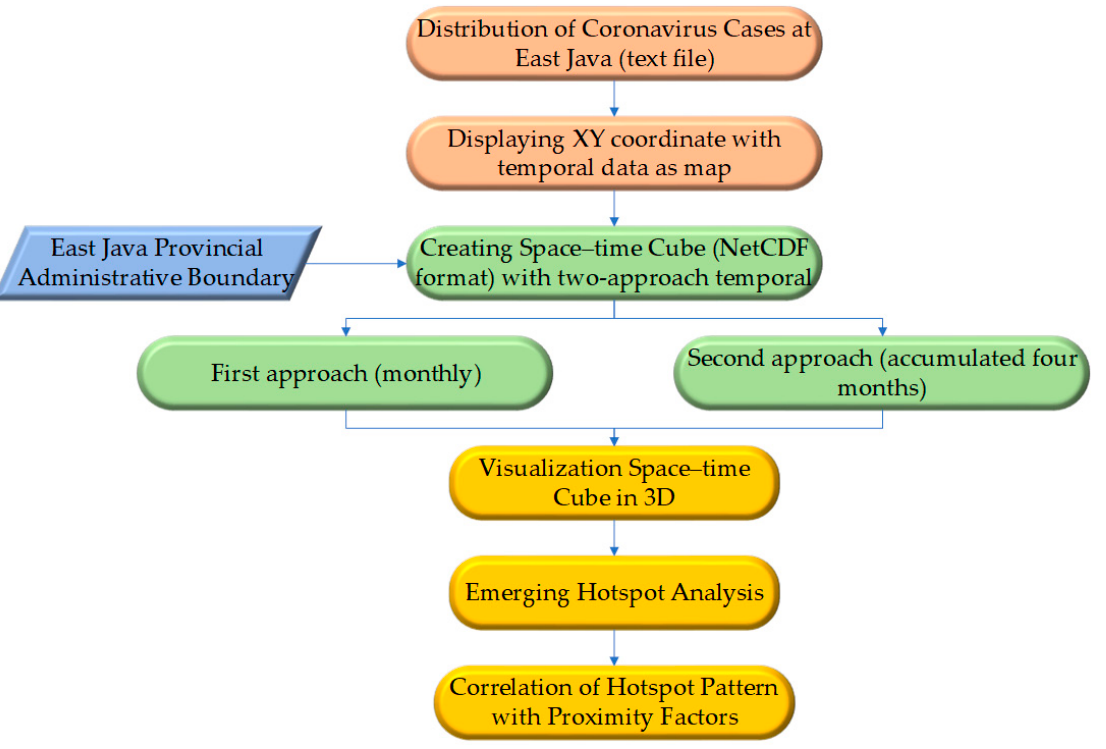
Figure 2. Research workflow for 3D visualization of space–time cube (STC), emerging hotspot analysis, and correlation of hotspot pattern with proximity factors.